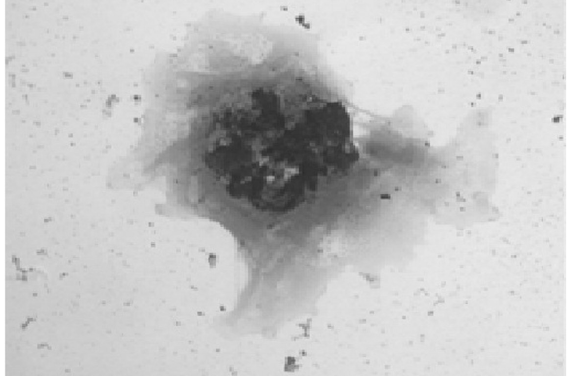
Fig. 3. The Alizarin Red stain.